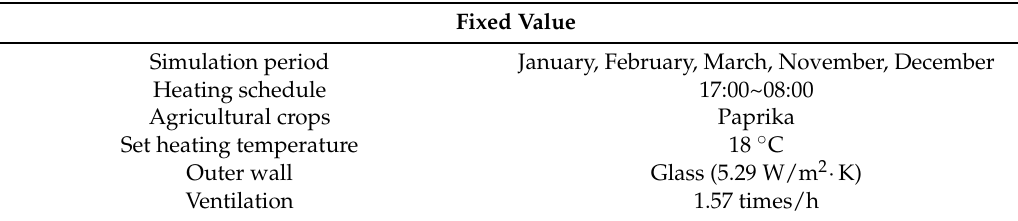
Table 3. Simulation